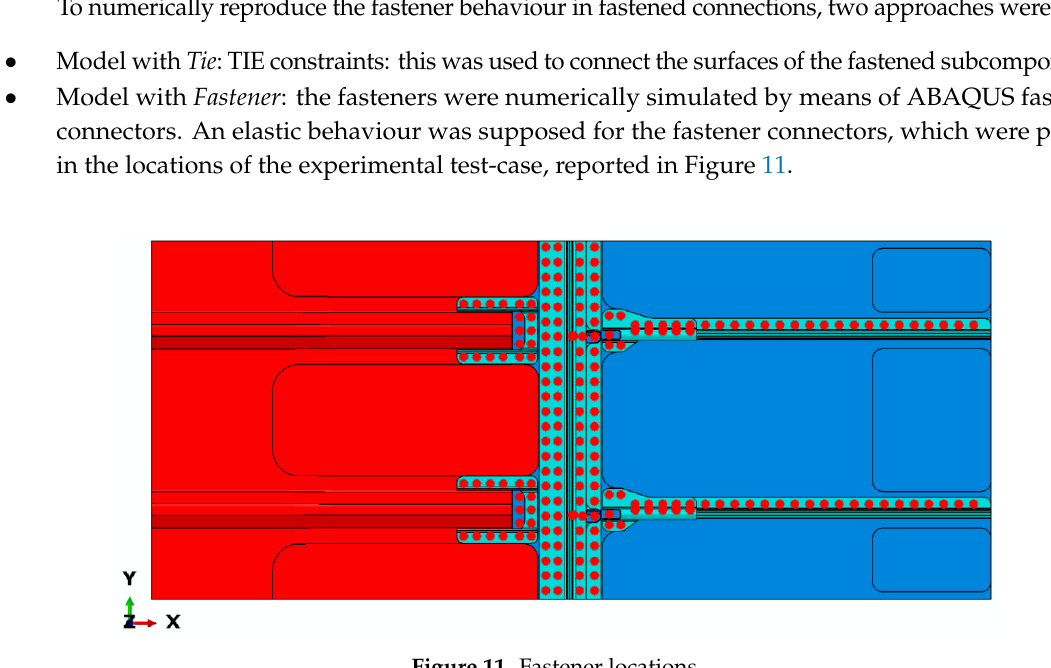
Figure 11. Fastener locations.